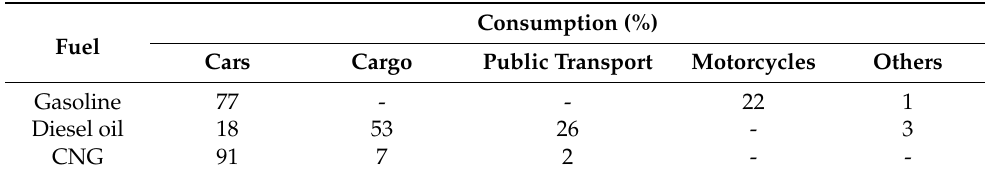
Table 1. Fuel consumption by vehicle category